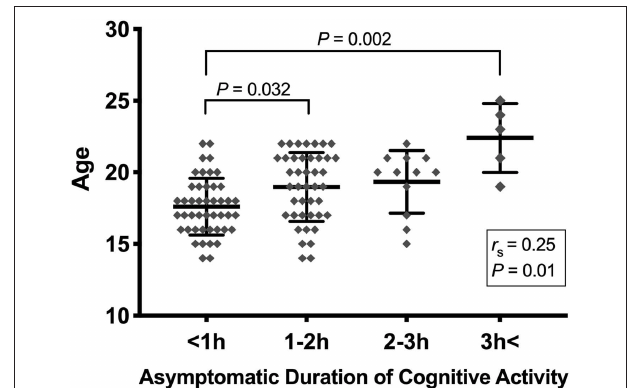
FIGURE 1 | Asymptomatic duration of cognitive activity by age. The relationships between age and length of cognitive activity without experiencing concussion symptoms were evaluated by Kruskal–Wallis test. Significance difference was observed between less than 1h and 1–2h ( p = 0.032), and between less than 1h and more then 3h ( p = 0.002). The asymptomatic length of cognitive activity was positively correlated with age ( r s = 0.25, p =